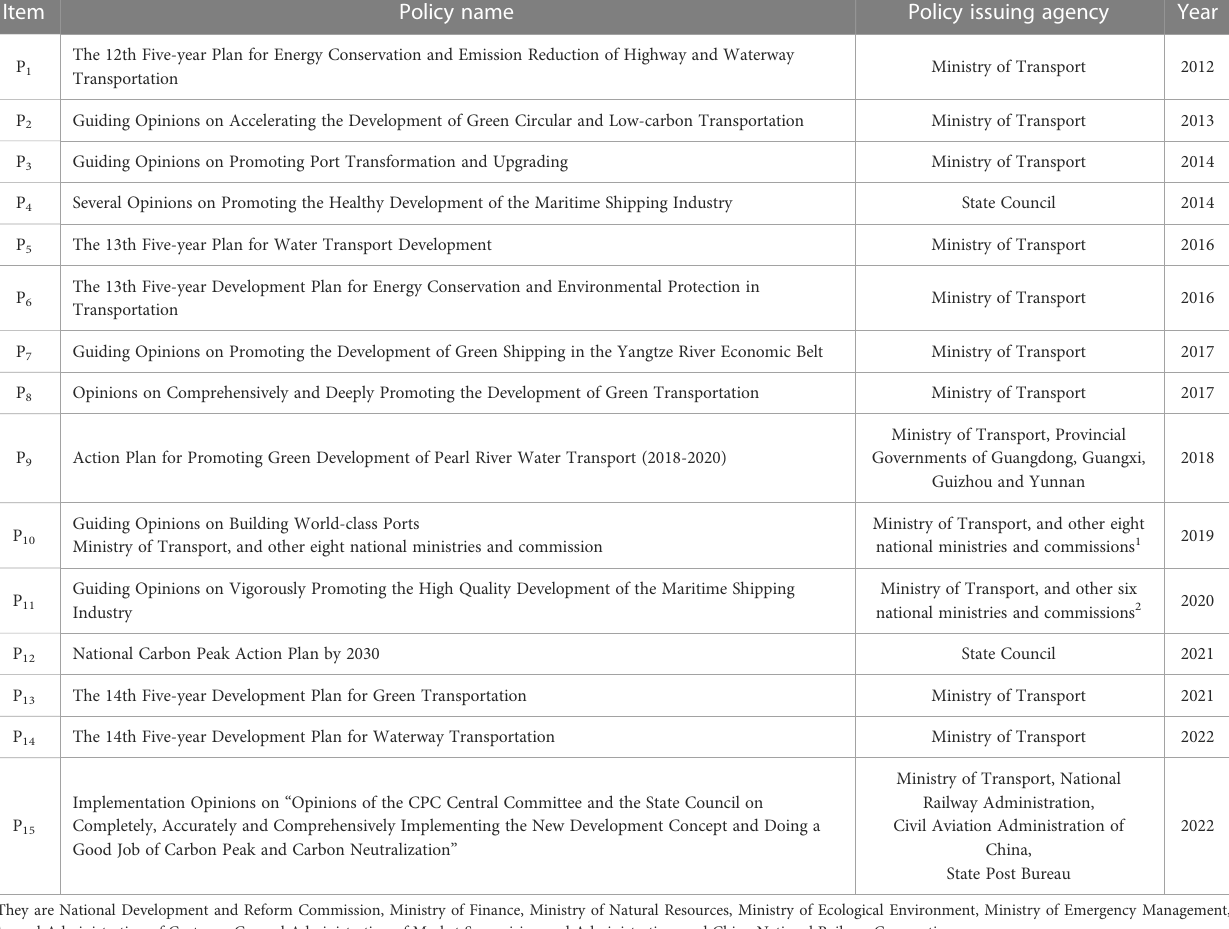
TABLE 1 China ’ s representative policies related to shipping decarbonization since 2012.